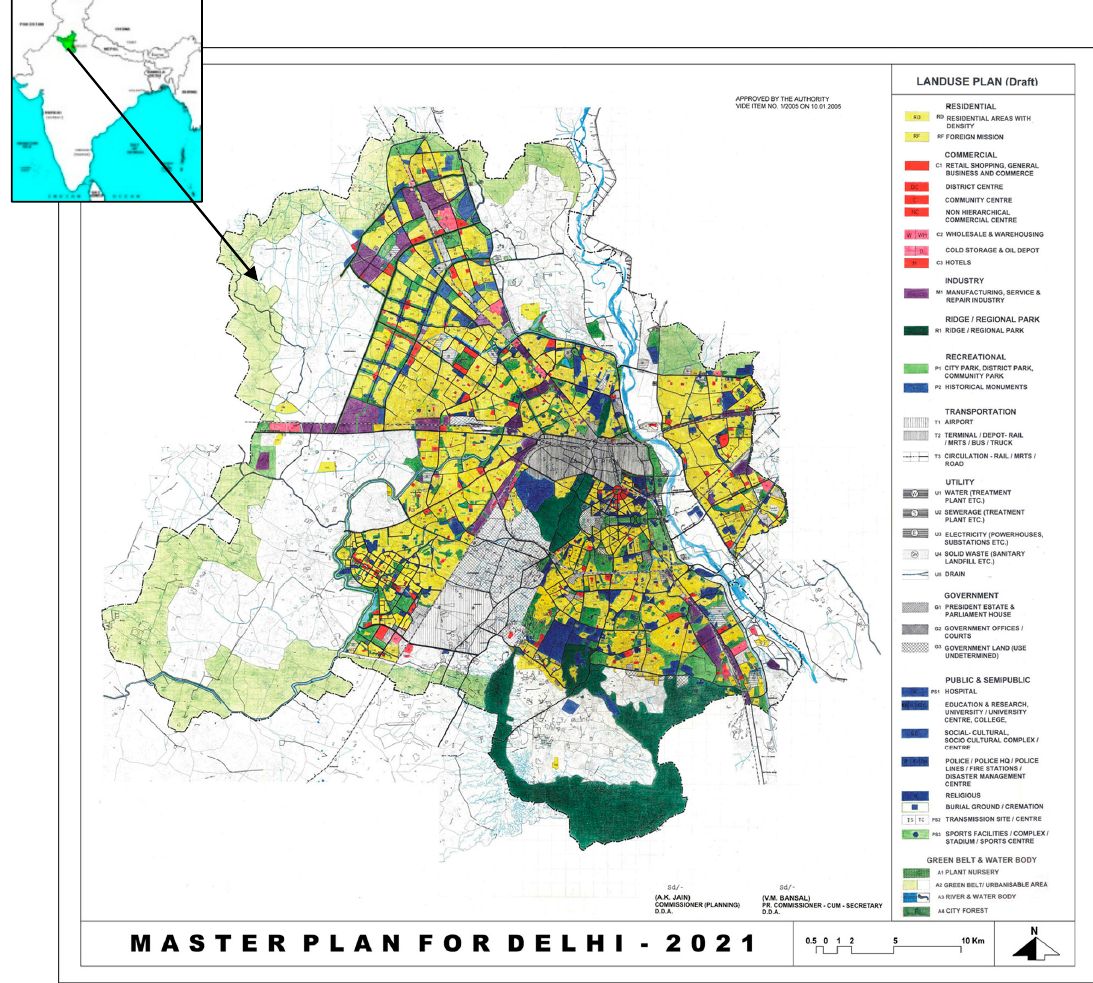
Figure 1. Masterplan of New Delhi, 2021